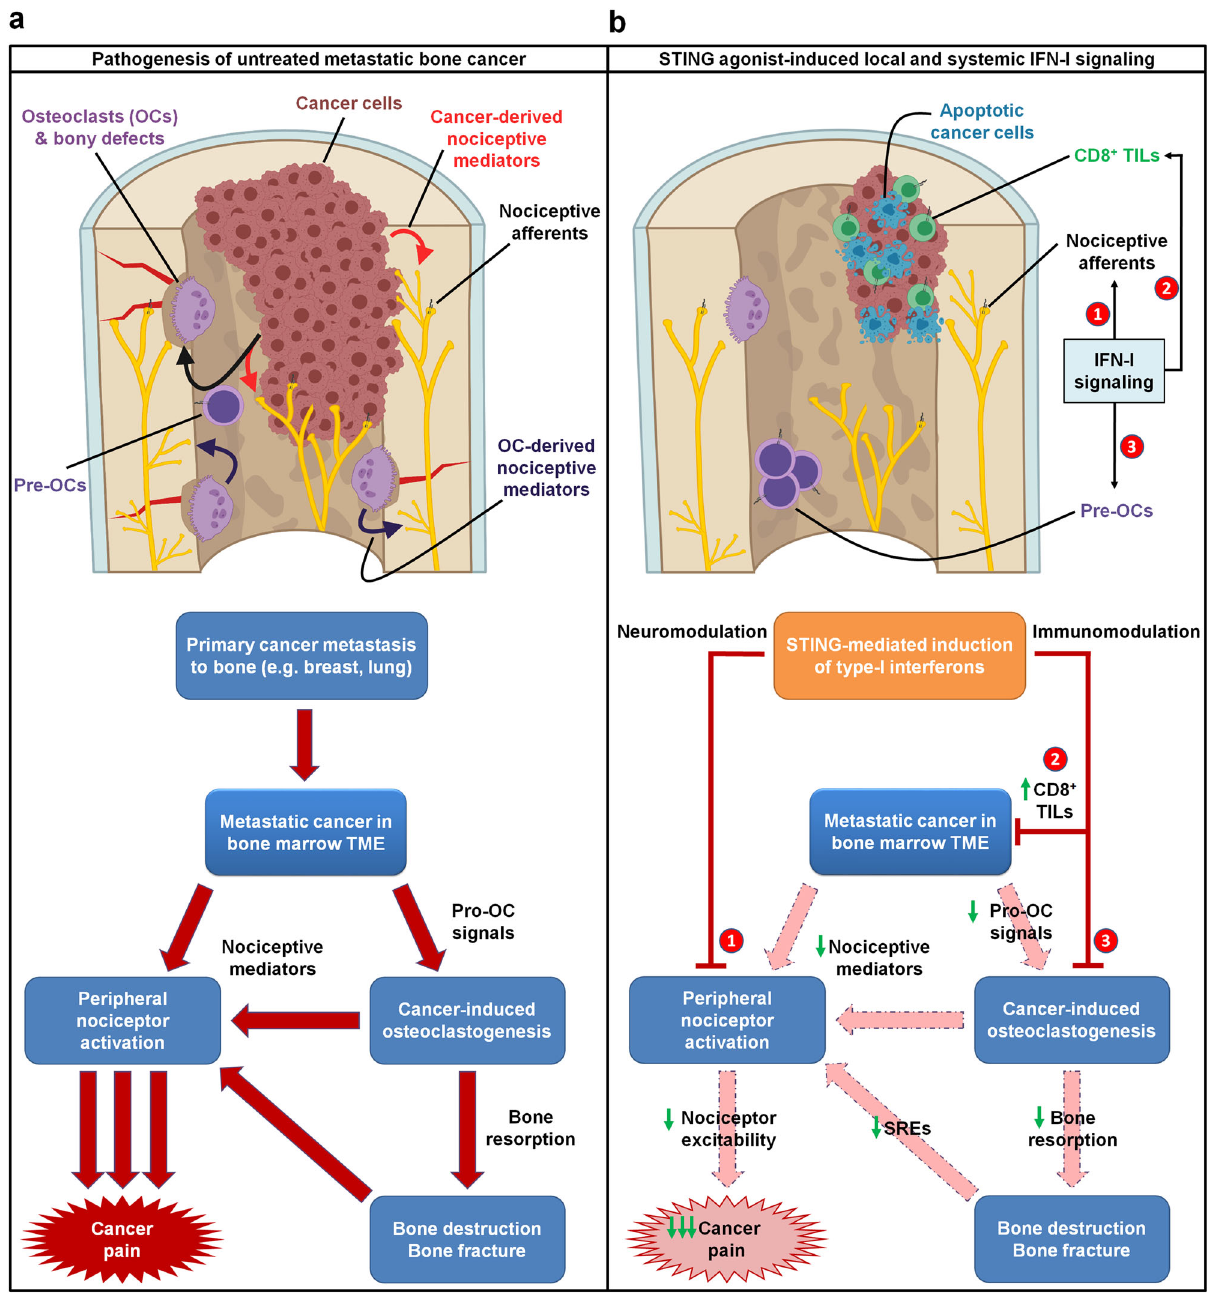
Fig. 10 Schematic of mechanisms by which STING agonists directly and indirectly attenuate bone cancer-induced pain. a In untreated metastatic bone cancer, the pathophysiology driving cancer pain is multifaceted. Metastatic cancer cells present within the bone marrow tumor microenvironment (TME) produce pro-osteoclastogenic signals, driving cancer-induced osteoclastogenesis and osteoclast overactivation. Both cancer cells and osteoclasts produce nociceptive mediators, which directly activate peripheral nociceptive afferents present in the TME to produce pain through a direct mechanism. Additionally, cancer-induced osteoclast overactivation also leads to increased bone resorption, leading to increased bone destruction and bony fractures, which also produce pain through nociceptor activation. b STING agonists dramatically attenuate metastatic bone cancer-associated pain through multiple mechanisms, each mediated by host-intrinsic type-I interferon signaling. First, STING-mediated IFN-I signaling directly suppresses excitability of peripheral nociceptors (neuromodulation), leading to acute suppression of pain for the duration of the IFN-I response. In addition, STING-mediated IFN-I signaling promotes CD8 + T cell migration into the bone marrow TME, augmenting antitumor immunity and reducing tumor burden. In addition, IFN-I drives suppression of cancer-induced osteoclastogenesis. These two non-neuronal, immunomodulatory effects lead to sustained inhibition of pain by (1) reducing cancer cell- and osteoclast-derived pro-nociceptive mediators and (2) reducing osteoclast-mediated bone resorption, thereby attenuating subsequent bone destruction and bony fractures that frequently evoke pain and skeletal-related events (SRE). Thus, the immunomodulatory and neuromodulatory effects of STING agonists each individually suppress pain through actions on different cell types, and also synergistically suppress cancer pain through a convergence of shared downstream actions. Pre-OCs pre-osteoclasts, TILs tumor in fi ltrating lymphocytes.